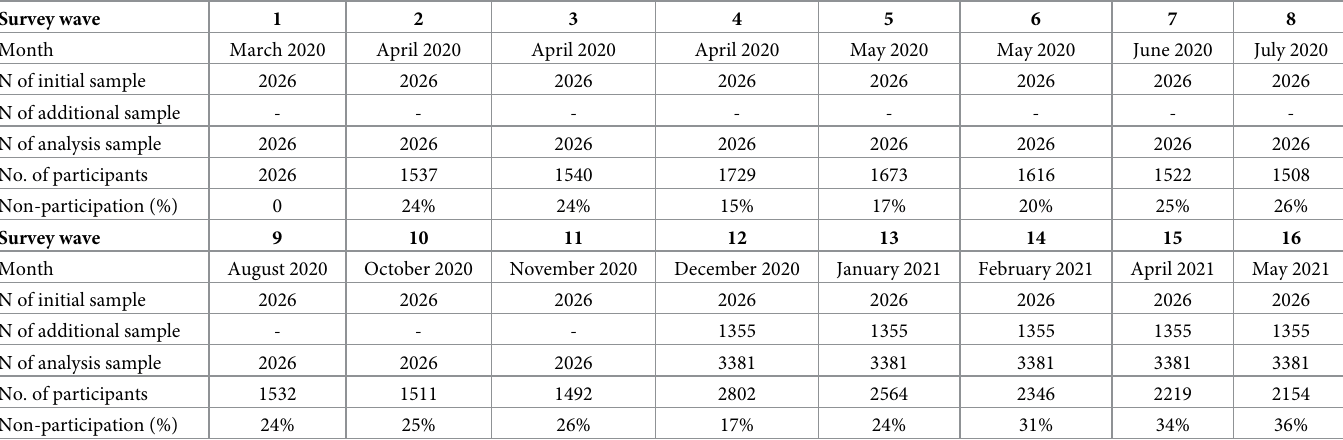
Table 1. Schematic overview of COVID-19 Social Monitor survey